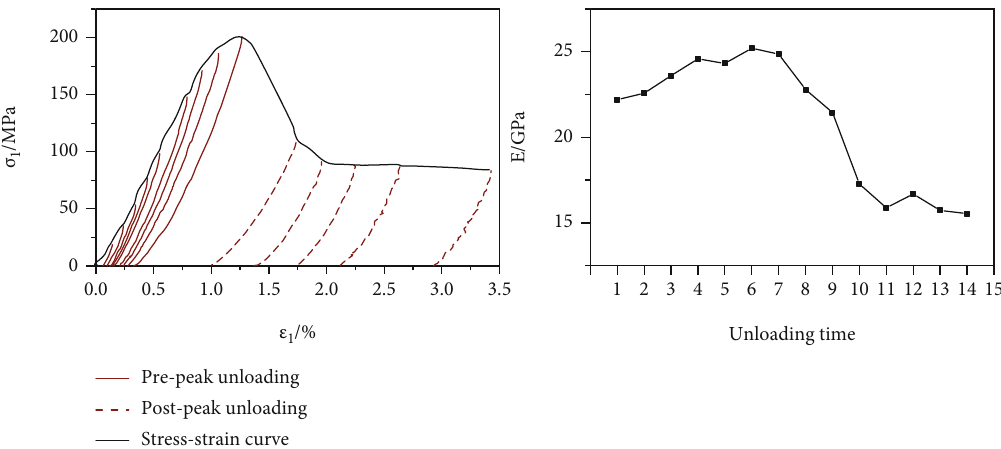
Figure 6: Unloading curves and evolution of elastic modulus under 20MPa con fi ning